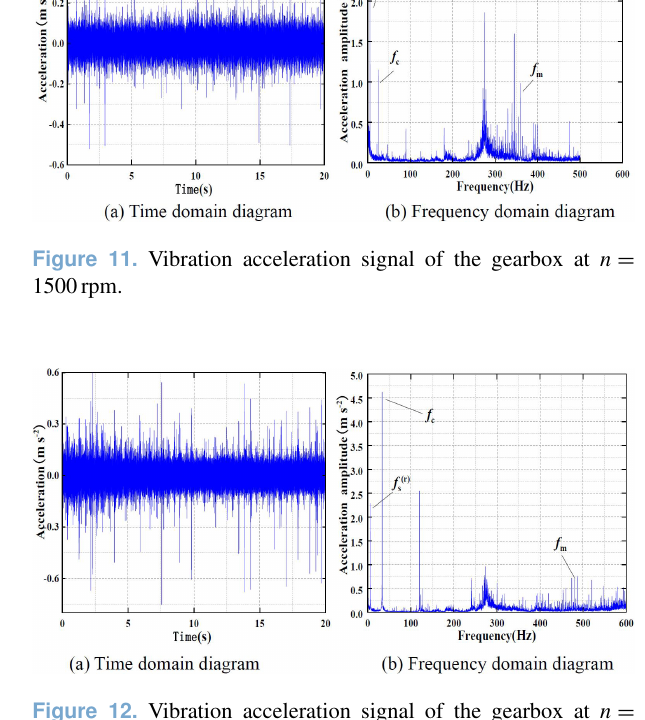
Figure 12. Vibration acceleration signal of the gearbox at n =